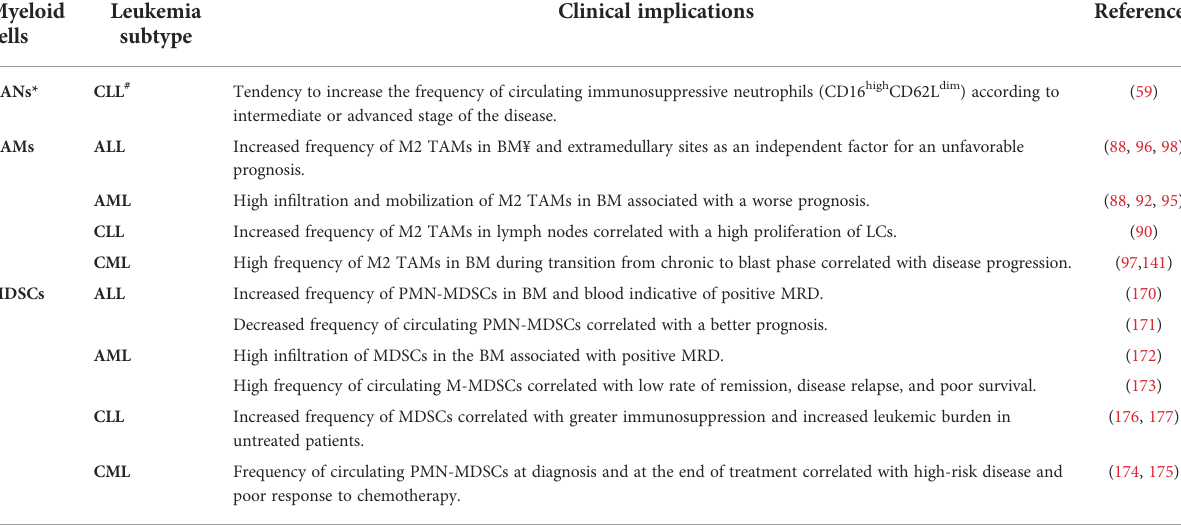
*TANs, tumor-associated neutrophils; TAMs, tumor-associated macrophages; MDSCs, myeloid-derived suppressor cells; # CLL, chronic lymphocytic leukemia; ALL, acute lymphoblastic leukemia; AML,acute myeloidleukemia; CML,chronic myeloidleukemia; ¥ BM, bone marrow;LCs,leukemic cells; PMN-MDSCs,polymorphonuclear MDSCs;MRD, Measurable residual disease; M-MDSCs, monocytic myeloid-derived suppressor